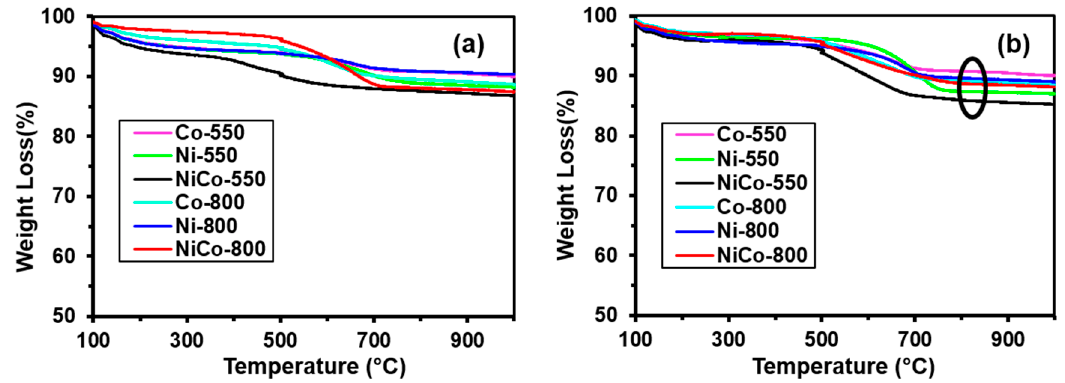
Figure 4. TGA profiles for spent Ni and/or Co-based catalysts calcined at 550 °C and at 800 °C after tests at ( a ) 700 °C and ( b ) 800 °C.